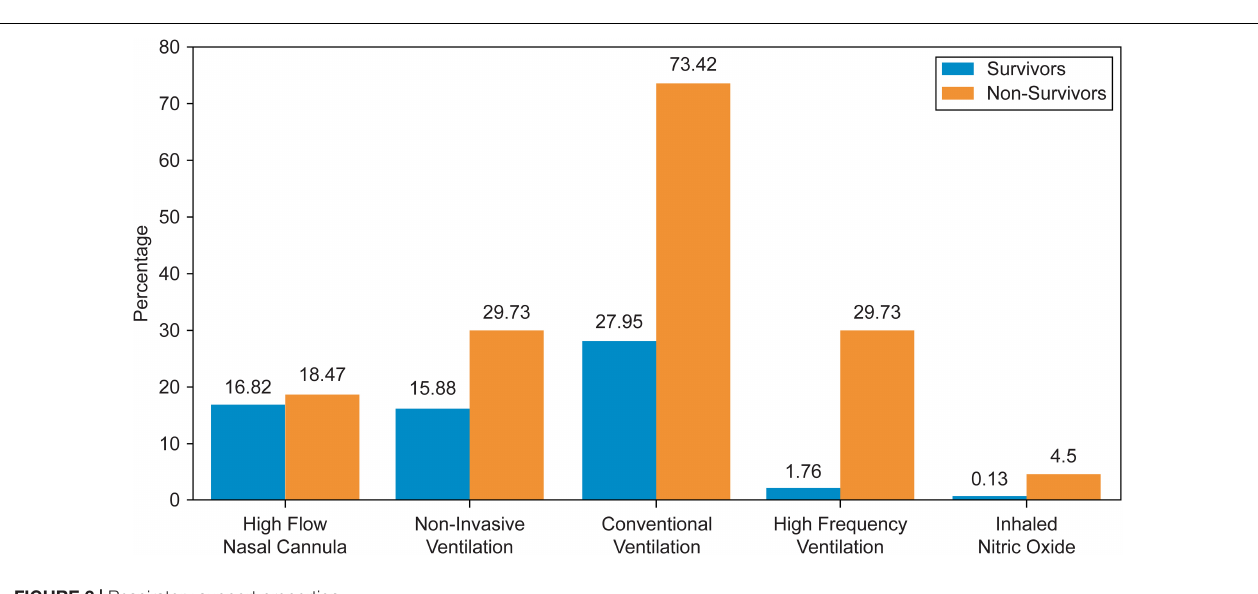
FIGURE 1 | Procedures proportion.